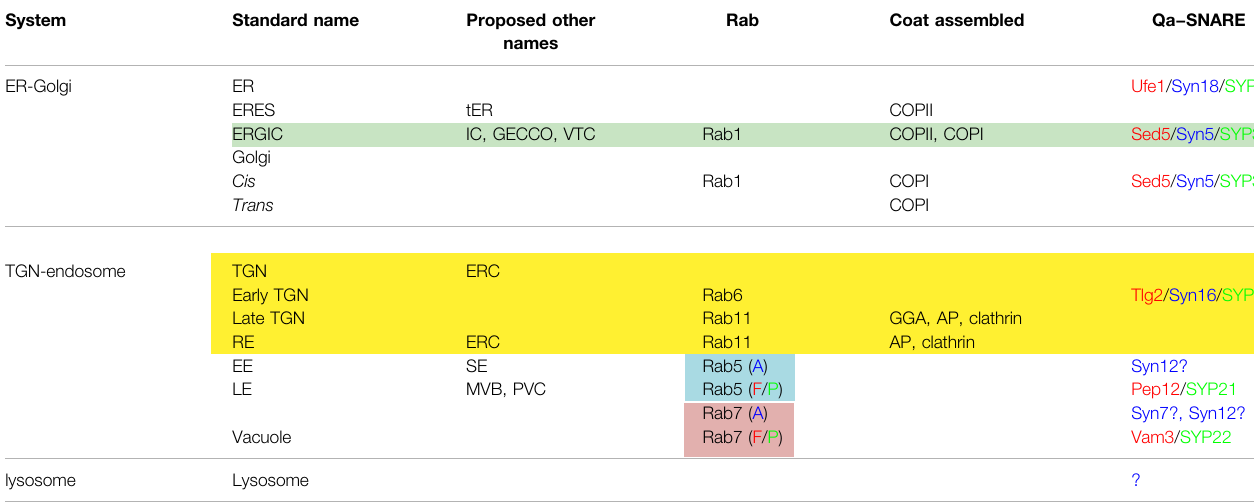
TABLE 1 | Membrane traf fi cking compartments and well-conserved Rab GTPases.